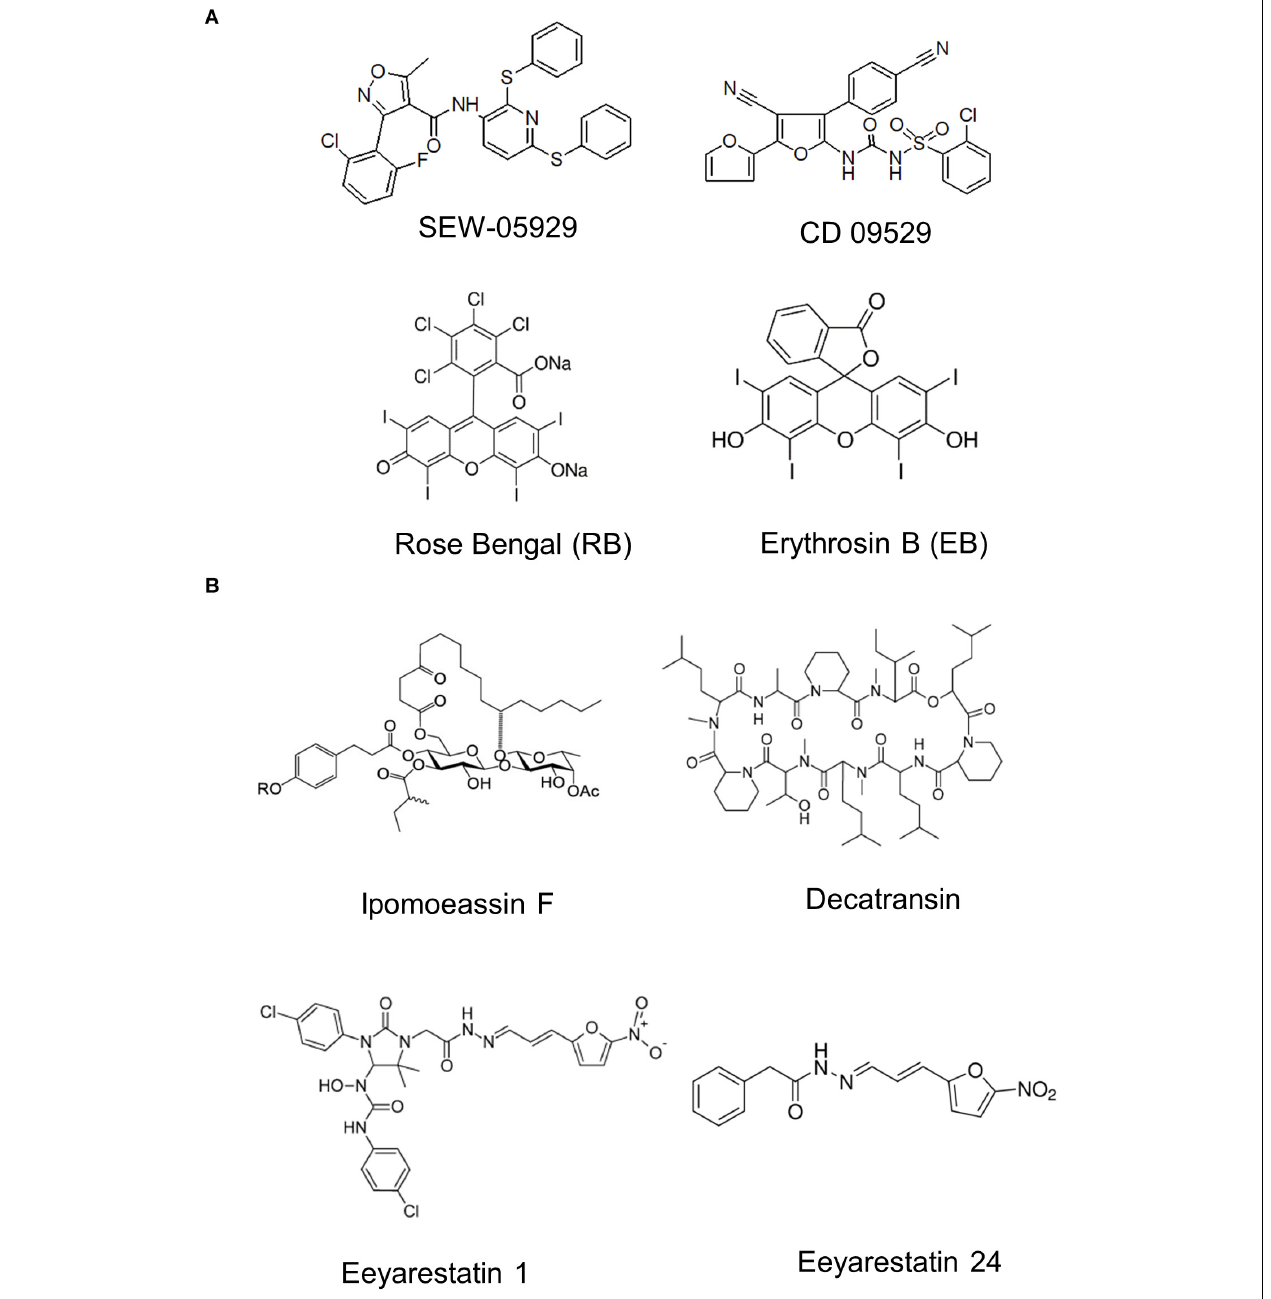
FIGURE 13 | Inhibitors of bacterial protein translocation. (A) Inhibitors of the ATPase SecA. (B) Inhibitors of the SecYEG-translocon. Ipomeassin F, decatransin, eeyarastatin 1 and eeyarastatin 24 also act on the homologous Sec61 complex in eukaryotes. Chemical structures were retrieved from the Sigma Aldrich web resource (https://www.sigmaaldrich.com/) or adapted from (Li et al., 2008; Van Puyenbroeck and Vermeire, 2018; Zong et al.,